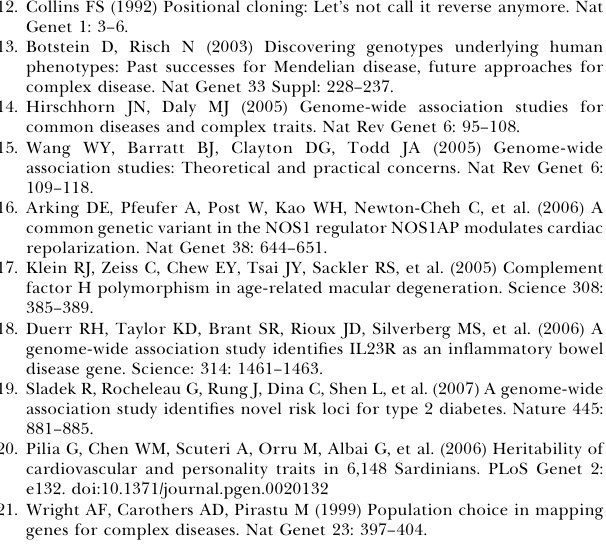
Table S1. Genotype Data for Sardinian Cohort Table S2. Results of Stepwise Analysis to Identify Independent Risk Alleles To generate this table, we first sought the most significantly associated allele in the genome. We then added this allele to our baseline model and repeated our genome scan to identify the next associated SNPs. Table S3. Tag SNP That Shows Strongest Association with BMI for Each Previously Identified Candidate Gene The first column indicates the name of a previously identified candidate. The second column indicates the number of SNPs in our Affymetrix arrays that are either in the gene or constitute the best available tag (r 2 . 0.5) for a genic SNP. The next column indicates the number of HapMap SNPs within þ / (cid:2) 5 kb of the gene and the proportion of these that are covered at r 2 . 0.50 or r 2 . 0.80. The next columns indicate the SNP that showed strongest association in our analysis, the p -value, the tested allele and its frequency, and the estimated additive effect. The last column corresponds to the FDR incurred when all tested SNPs are considered and this test is declared significant. Table S4. Tag SNP That Shows Strongest Association with Hip Circumference for Each Previously Identified Candidate Gene The first column indicates the name of a previously identified candidate. The second column indicates the number of SNPs in our Affymetrix arrays that are either in the gene or constitute the best available tag ( r 2 . 0.5) for a genic SNP. The next column indicates the number of HapMap SNPs within þ / (cid:2) 5 kb of the gene and the proportion of these that are covered at r 2 . 0.50 or r 2 . 0.80. The next columns indicate the SNP that showed strongest association in our analysis, the p -value, the tested allele and its frequency, and the estimated additive effect. The last column corresponds to the FDR incurred when all tested SNPs are considered and this test is declared significant. Table S5. Tag SNP That Shows Strongest Association with Weight for Each Previously Identified Candidate Gene The first column indicates the name of a previously identified candidate. The second column indicates the number of SNPs in